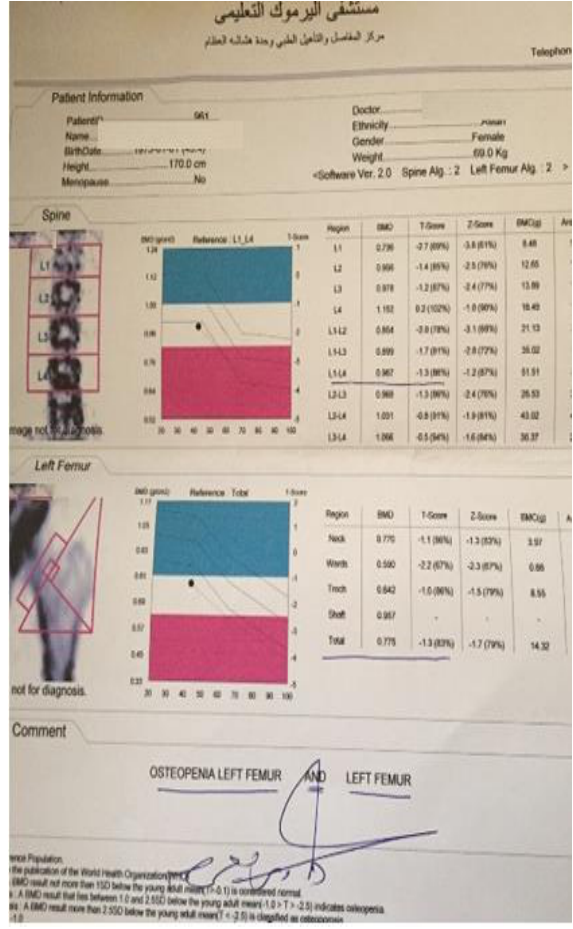
Figure 2 below showed an example of osteopenia result in one of our patients